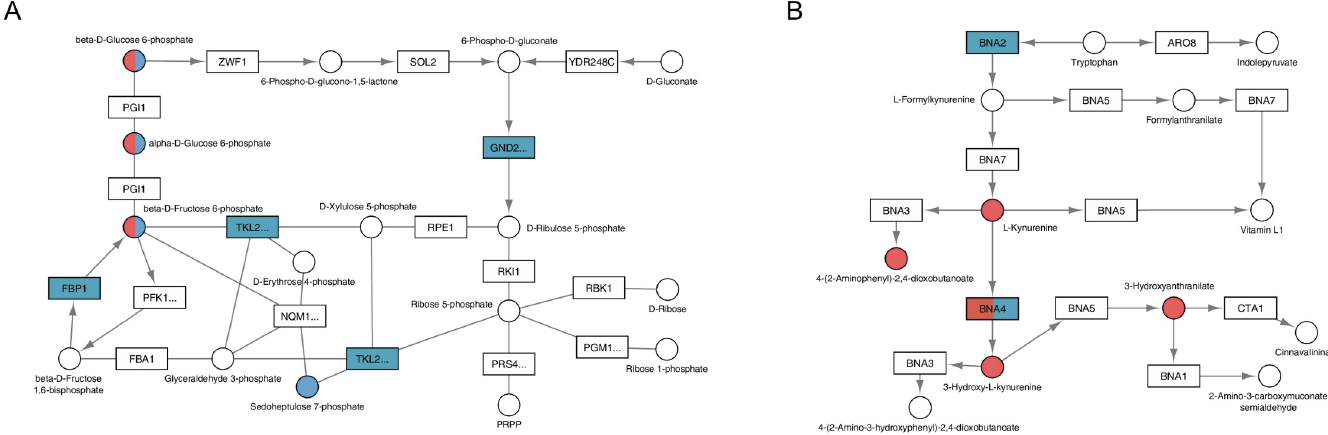
Fig 4. KEGG pathways regulated by GPA2 or ASC1 as determined by concentration analysis. The relevant part of a specific KEGG pathway is shown with genes displayed as rectangles and metabolites displayed as circles. KEGG compound name for each metabolite is labeled beside the circle. Standard gene names are labeled inside the rectangle. For enzyme complexes, the gene name for the major component is shown followed with an ellipsis. The directions of irreversible enzymatic reactions are shown by the arrows. Reversible reactions are connected by straight lines. DEGs and SPMs are highlighted in blue ( gpa2 ) and red ( asc1 ). Shared DEGs and SPMs are colored half blue and half red. A) as compared with asc1 , gpa2 affected more components in pentose phosphate pathway (functional category: carbohydrate); B) as compared with gpa2 , asc1 affected more components in tryptophan metabolism (functional category: amino acid).